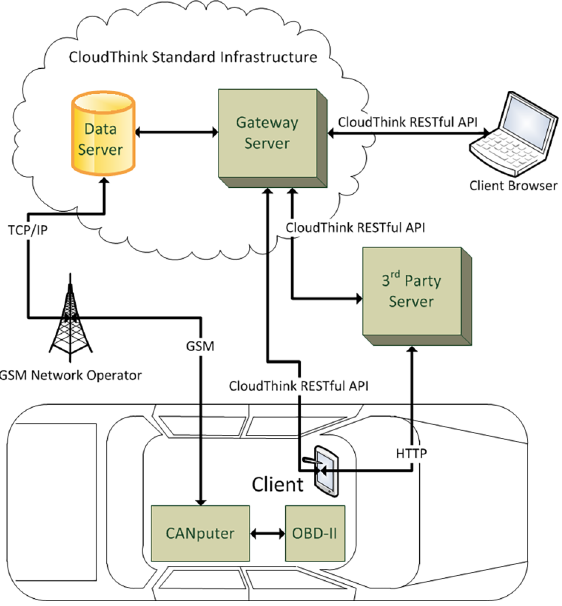
Fig. 1. CloudThink system architecture showing how the CARduino and the CloudThink Standard Infrastructure interact with 3rd party servers